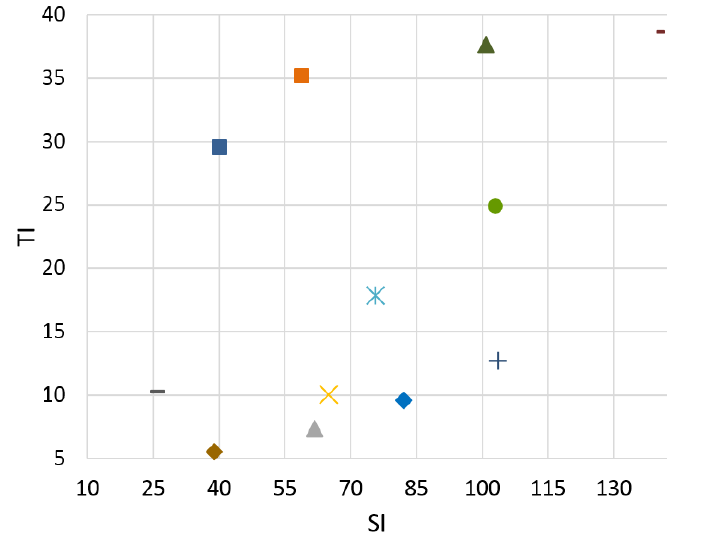
Figure 7. FULL HD, H.265, bitrate 20 Mbps.